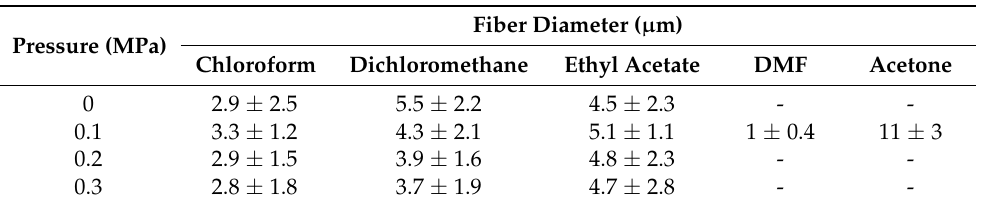
Table 2. Measured fiber diameter of the fabricated